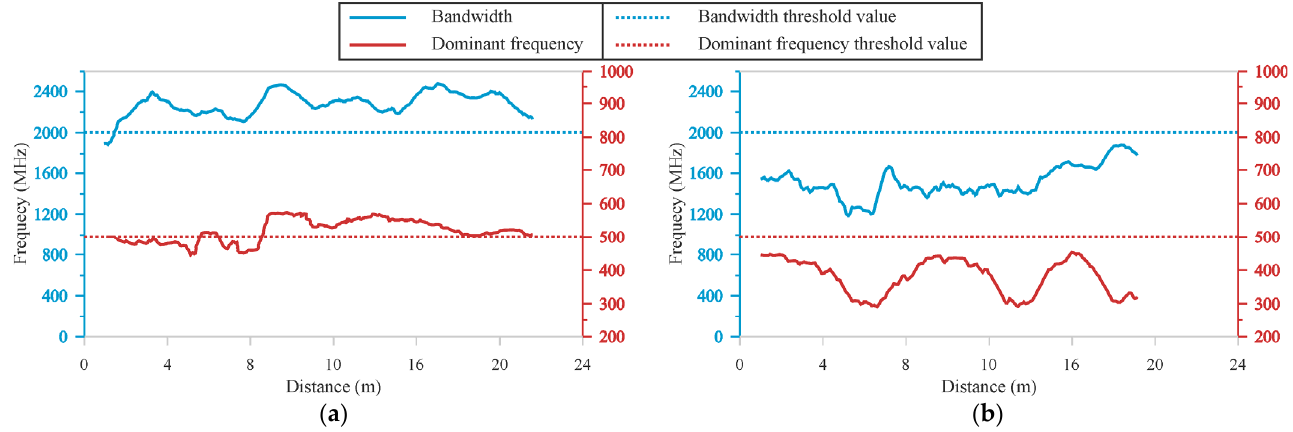
Figure 5. Examples of the results obtained for an area free of contaminant ( a ) and with the presence of LNAP ( b ).